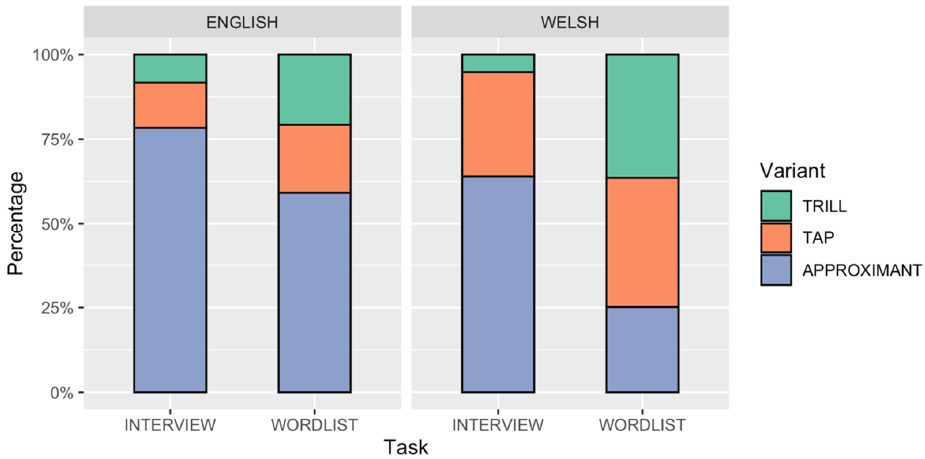
Figure 3. Distribution of /r/ variants in the Caernarfon Welsh-language subset by home language and task ( n = 799).